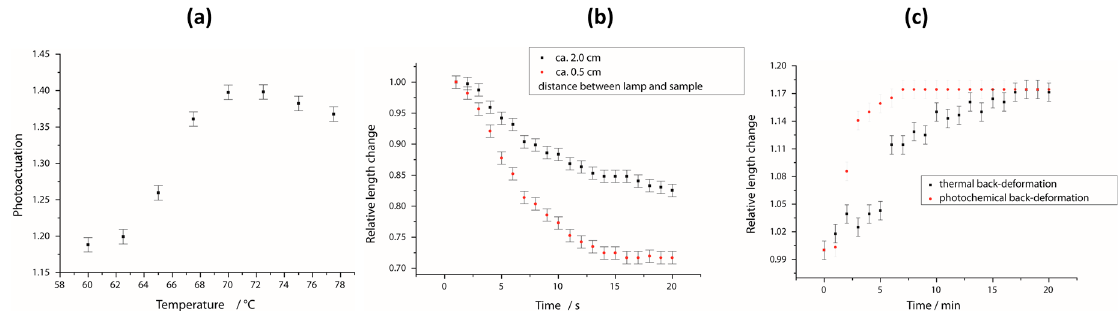
Figure 7. Photoresponsive behavior of this LCE system. ( a ) The photoactuation of an LCE film for different temperatures during the irradiation; ( b ) time dependence of the photoactuation for two different light intensities (distances between lamp and sample); ( c ) time dependence of the back-deformation of the sample, induced either by red light or by keeping the film in the dark (isothermal back-deformation).